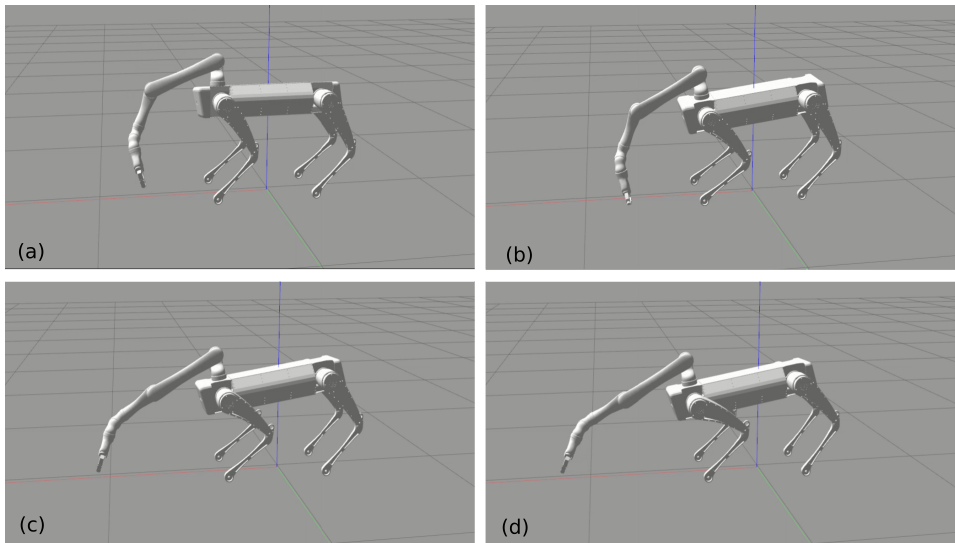
Figure 3. Automatic adaptation of the torso’s pose. When the end-effector, which has higher priority in the hierarchical controller, reaches its limits, the torso automatically follows the end-effector so that it extends the reachable workspace of the end-effector. ( a ) Touching down. ( b ) Reaching the ground. ( c ) Reaching the arm’s limit. ( d ) Torso adapts to the arm’s motion.